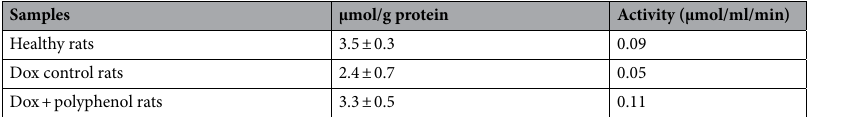
Table 5. Measurement of glutathione level and activity. The table shows the approximate glutathione level and activity from 3 different animal groups. Results presented are mean ± standard error of the mean of at least 3 independent experiments from 6 different